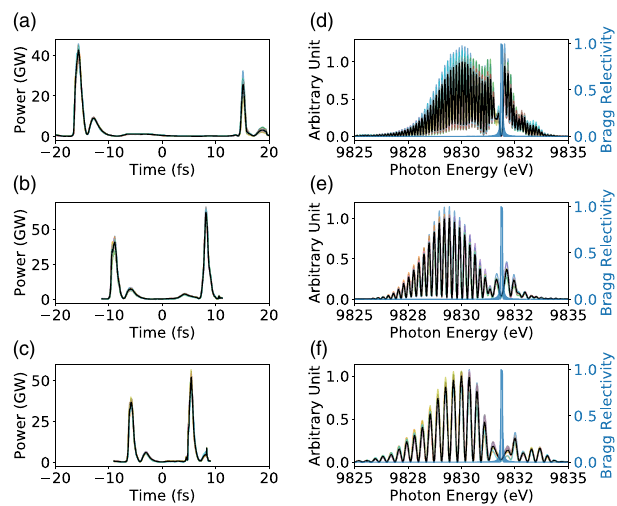
FIG. 8. Pulse pairs outcoupling. Ten shots of outcoupled radiation from shaped beam (a – c) and their spectrum (d – f), with delay time at 9.5 fs (a,d) 17.3 fs (b,e), and 31.0 fs (c, f) respectively. The colored line for each shot and the black line for the average. Bragg reflectivity, as a function of photon energy, is shown by the blue dash line in (d – f).